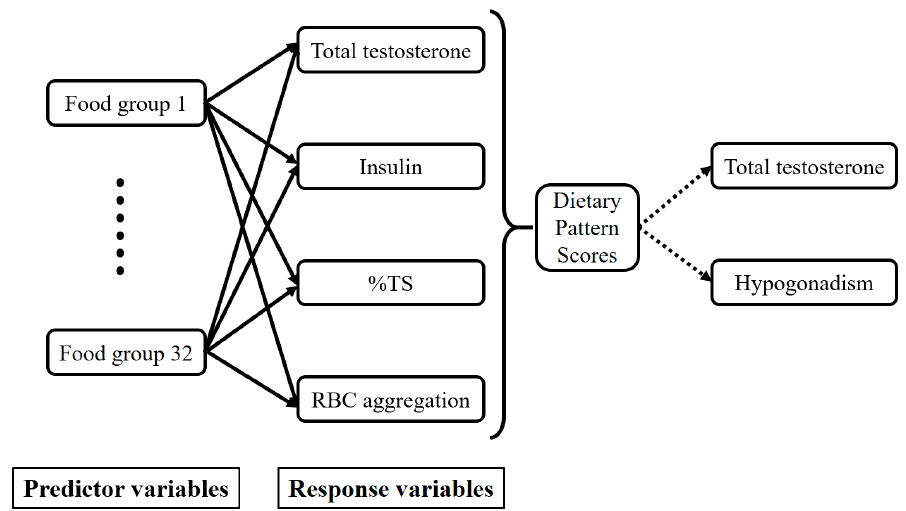
Figure 1. Directed acyclic graph of the reduced rank regression (RRR) conceptual framework. TS: transferrin saturation